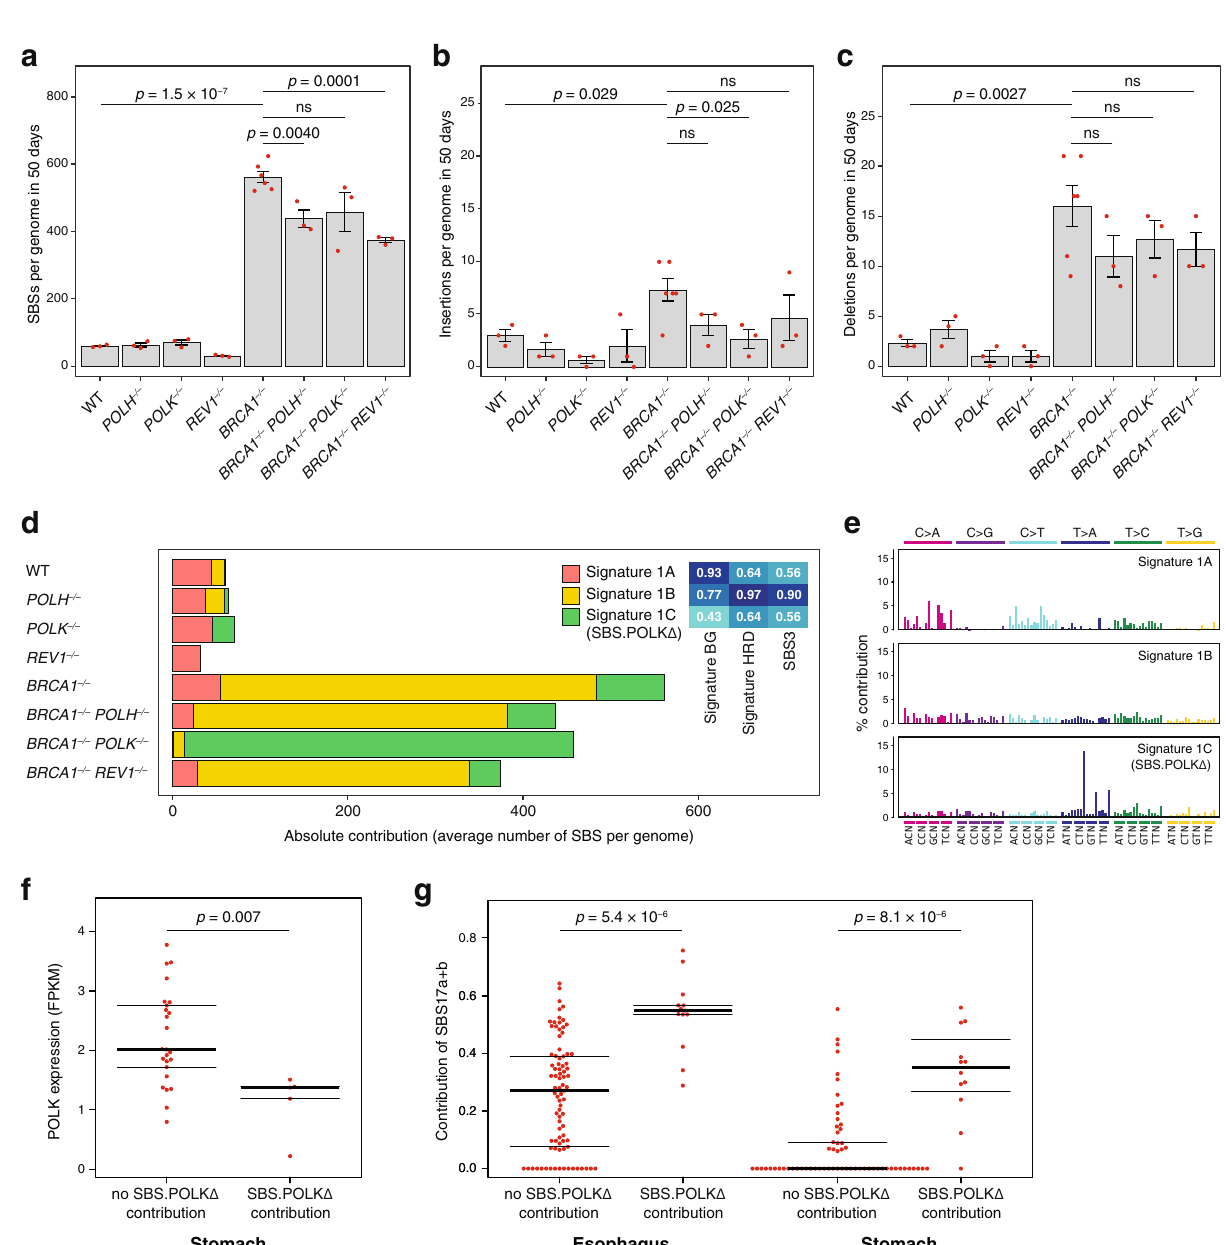
Fig. 1 TLS plays a role in spontaneous mutagenesis in BRCA1 de fi cient cells. The mean number of newly arising SBS (single base substitution, a ), insertion ( b ) and deletion ( c ) mutations detected in DT40 cell clones of the indicated genotypes following 50 days of culturing an ancestral clone. Error bars indicate standard error of the mean (SEM), individual values are also shown with red symbols. The signi fi cance of tested differences is shown (ns not signi fi cant, unpaired two-sided t -test, n = 3 biologically independent samples except n = 6 for BRCA1 – / – cells). d Deconstruction of the averaged spontaneous triplet SBS spectra of the indicated genotypes into three mutational signatures using non-negative matrix factorisation. The inset shows cosine similarities to published triplet signatures, see text for details. e Triplet spectra of the mutational signatures derived in ( d ). Each mutation class, as indicated at the top of the panel, is separated into 16 categories based on the identity of the preceding and following nucleotide as shown below. The order of the following nucleotides, not shown due to lack of space, is alphabetical. f POLK expression level in all PCAWG stomach adenocarcinoma samples with RNAseq data, grouped according to whether >5% contribution of SBS.POLK Δ was detected in a deconstruction of the somatic mutation spectrum to all COSMIC v3 SBS signatures. g The summed contribution of COSMIC triplet signatures SBS17a and SBS17b to the somatic mutation spectrum in all PCAWG oesophagus or stomach adenocarcinoma samples, grouped according to SBS.POLK Δ contribution as in ( f ). The mean, upper and lower quartiles are shown in ( f ) and ( g ), statistical signi fi cances are indicated (Wilcoxon rank-sum test). Source data are provided as a Source Data fi